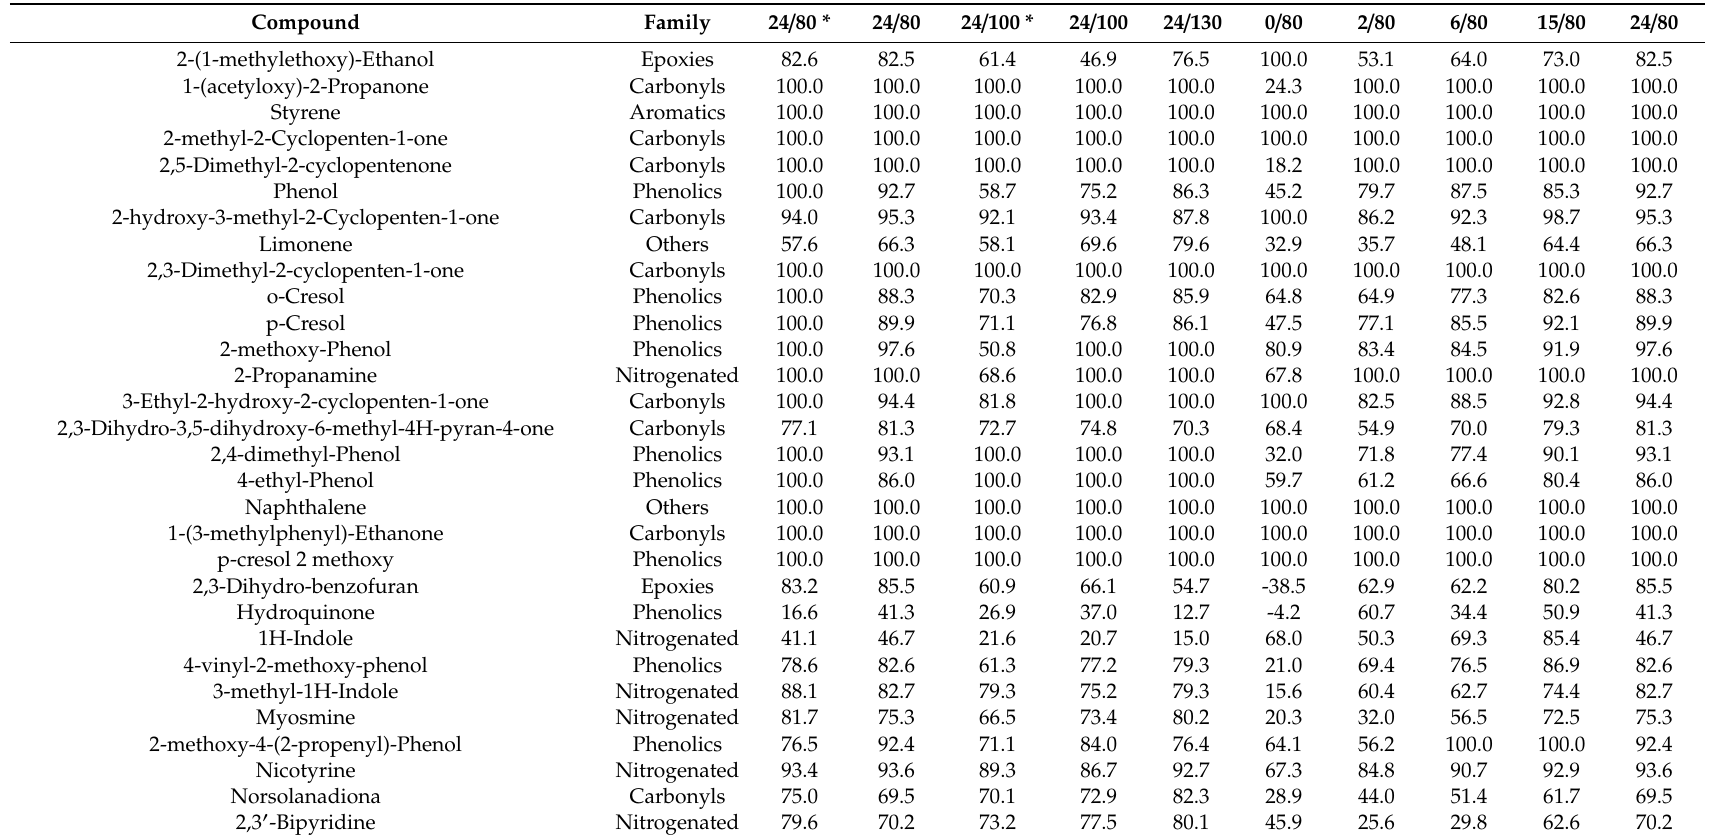
Table A2. Reduction percentages (%) of the di ff erent compounds identified in the collected fraction of the total particulate matter for the tobacco-catalyst mixtures respect to the 3R4F tobacco reference for the studies of time, temperature, and reduction of the supernatant liquor in the hydrothermal treatment. * Synthesis developed without reducing the supernatant liquor before the hydrothermal